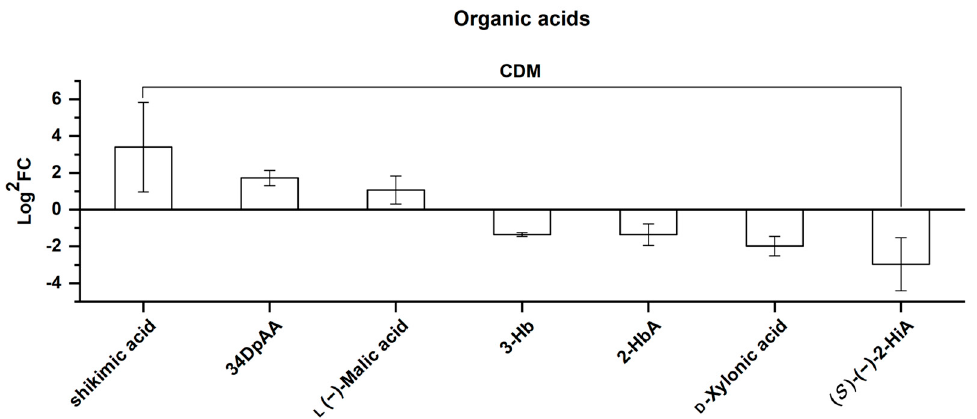
Figure 14. Comparison of organic acids, consisting of 7 CDMs between SJL and SN. Upregulation denotes that the content of a metabolite increased in SN compared with that in SJL, and the opposite for downregulation. The Y -axis is exhibited as Log 2 FC values for the convenience of visual presentation. The X -axis denotes the metabolite names. Abbreviation: 34DpAA, 3,4-dimethoxyphenyl acetic acid; 3-Hb, 3-hydroxybutyrate; 2-HbA, 2-hydroxybutanoic acid; ( S )-( − )-2-HiA, ( S )-( − )-2- hydroxyisocaproic acid.